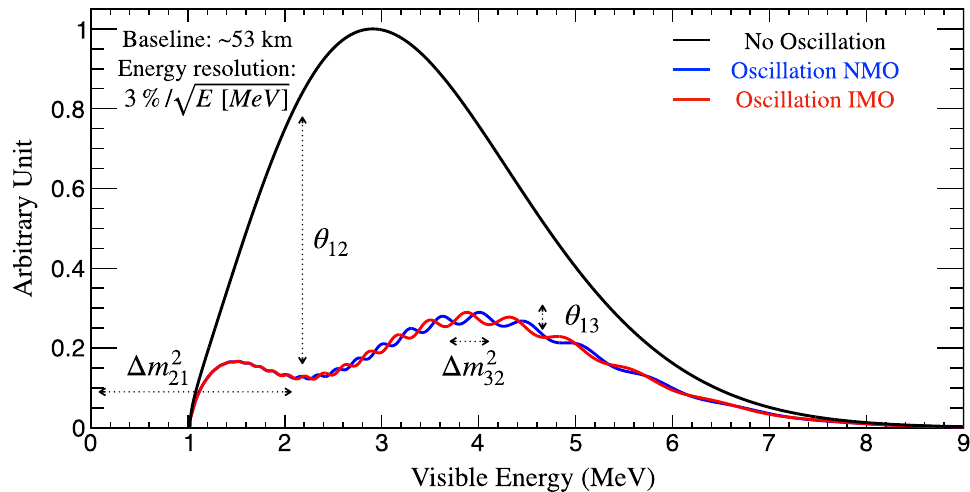
Figure 1. JUNO neutrino bi-oscillation spectral distorsion. JUNO was designed to exploit the spectral distortions from two oscillations simultaneously manifesting via reactor neutrinos in a baseline of ∼ 53 km. θ 12 and δ m 2 21 drive the slow and large amplitude ( sin 2 ( 2 θ 12 )/ 2 ≈ 42%) disappearance oscillation with a minimum at ∼ 2 MeV visible energy. The fast and smaller amplitude ( sin 2 ( 2 θ 13 )/ 2 ≈ 5%) disappearance oscillation is driven by θ 13 and (cid:31) m 2 32 instead. The θ 13 oscillation frequency pattern depends on (cid:31) m 2 32 ’s sign, thus directly sensitive to mass ordering (MO) via only vacuum oscillations. JUNO’s high statistics allow shape-driven neutrino oscillation parameter extraction, with minimal impact from rate-only systematics. Hence, high precision is possible without permanent reactor flux monitoring, often referred to as near detector (s). JUNO’s shape analysis relies on the reactor reference spectrum’s excellent control, implying high resolution, energy scale control, and a robust data-driven reference spectrum obtained with TAO 47 , a satellite experiment of JUNO. The here presented plot is for illustration purposes and the neutrino oscillation parameters are taken from NuFit5.0 (Table 1).